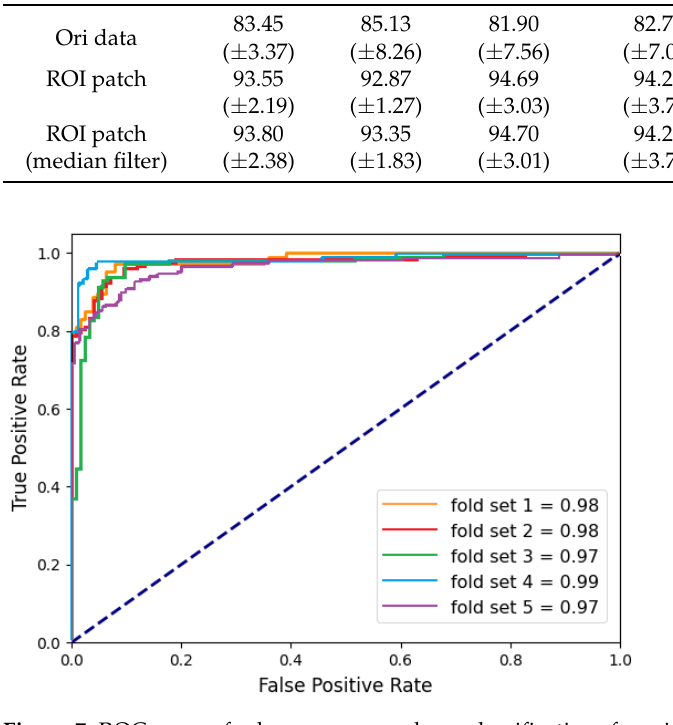
Figure 7. ROC curves for bone marrow edema classifications from individual MR slices. Table 3. Performance for final diagnosis of active sacroiliitis for each subject